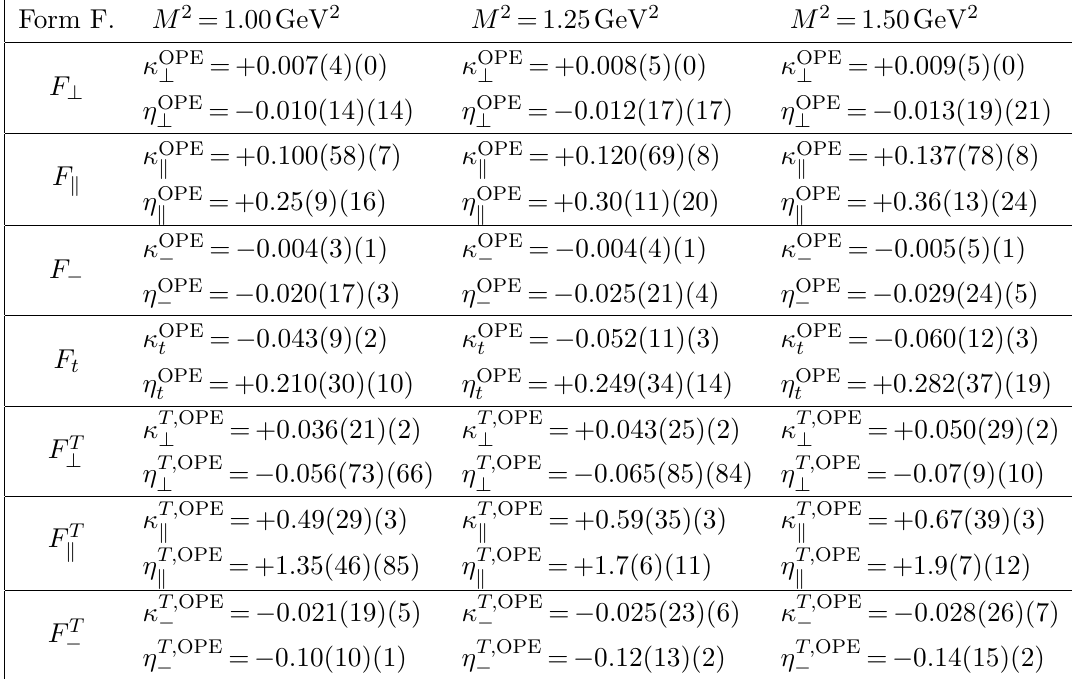
Table 4 . Results for the OPE coe(cid:14)cients in the z -expansion in Model I for the B -meson LCDAs. The (cid:12)rst error is parametric and the second one captures the model dependence from the LCDAs, as detailed in appendix